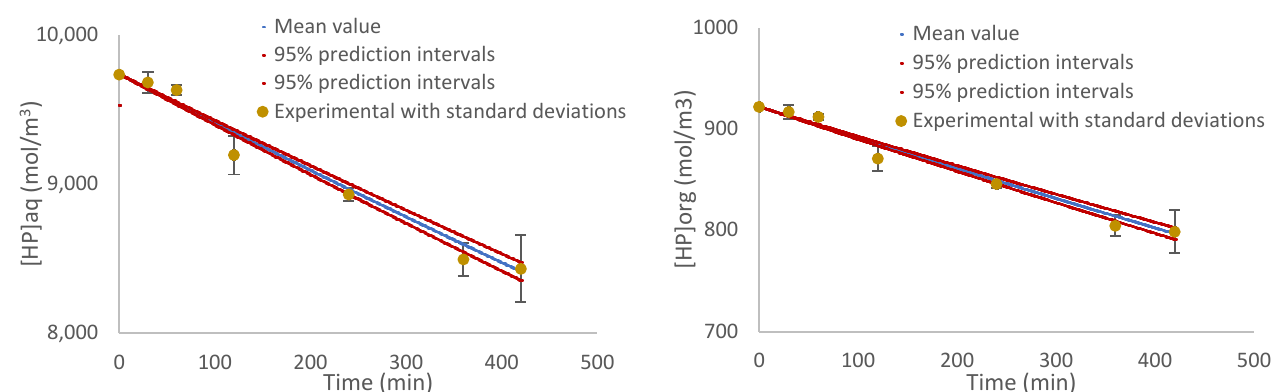
Figure A2. Prediction intervals of 95% for the concentration of hydrogen peroxide in the aqueous and organic phases, using the average of the experimental data and setting K 1,org = 0 and K 1,aq = 15.05 for Experiment 2.